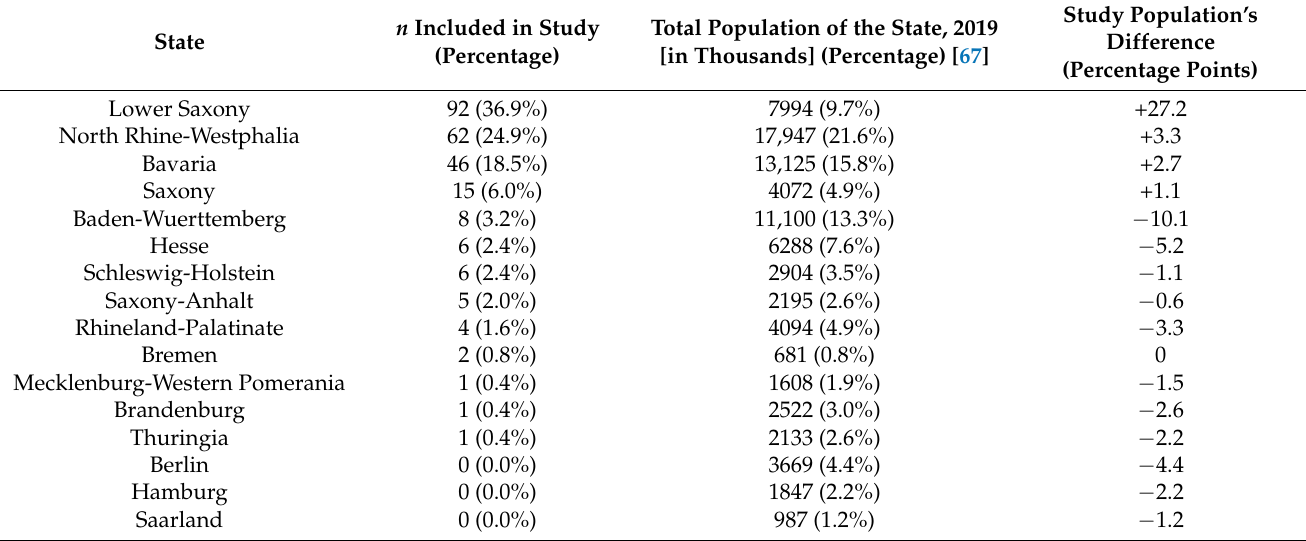
Table A1. Regional distribution of ALS patients included in this study compared with the regional distribution by state of the general population in Germany. The distribution of our patients roughly matches the regional population distribution by state in Germany. Due to rounding, percentages do not add up to exactly 100. Abbreviations: ALS, amyotrophic lateral sclerosis; n ,